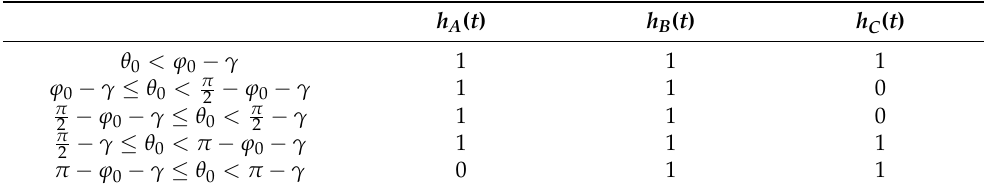
Table 1. The value of occlusion function for cone-shaped target scattering points.